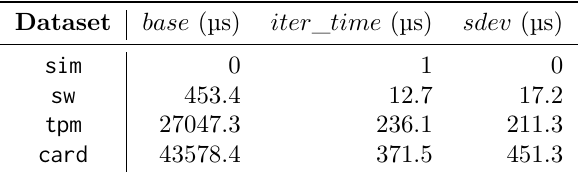
Table 2: Estimated parameters of the used datasets as given by the model in Equation